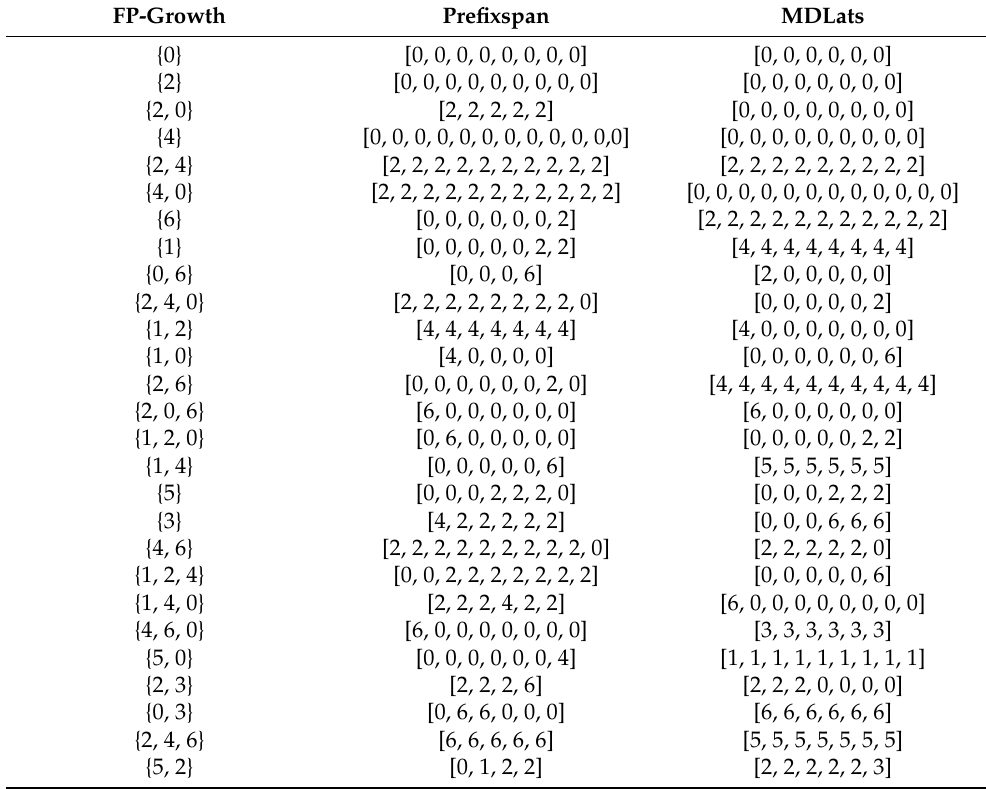
Table 5. Persistency patterns and motifs discovered by FP-Growth (left), Prefixspan (middle), and MDLats (right). Each row of data on the left represents frequent item, in the middle represents frequent sequence, and on the right represents motif. The occurrence frequency of each pattern or motif in the figure gradually decreased from top to bottom.